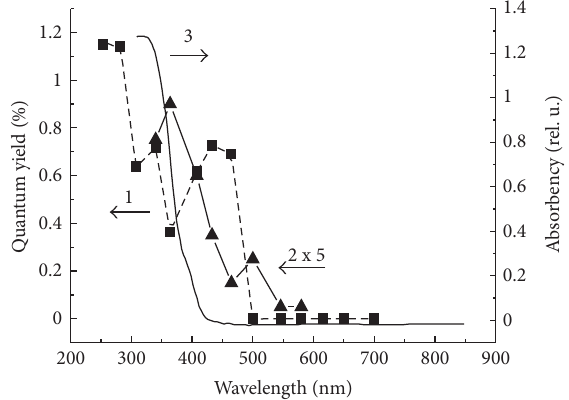
F 4: Kinetics of the variation of peaks 44 (1) and 51 (2) and Freon 22, respectively, of masses in the mass spectra of CO surface through the �� �lter in the under illumination of the TiO 2 presence of Freon. 2